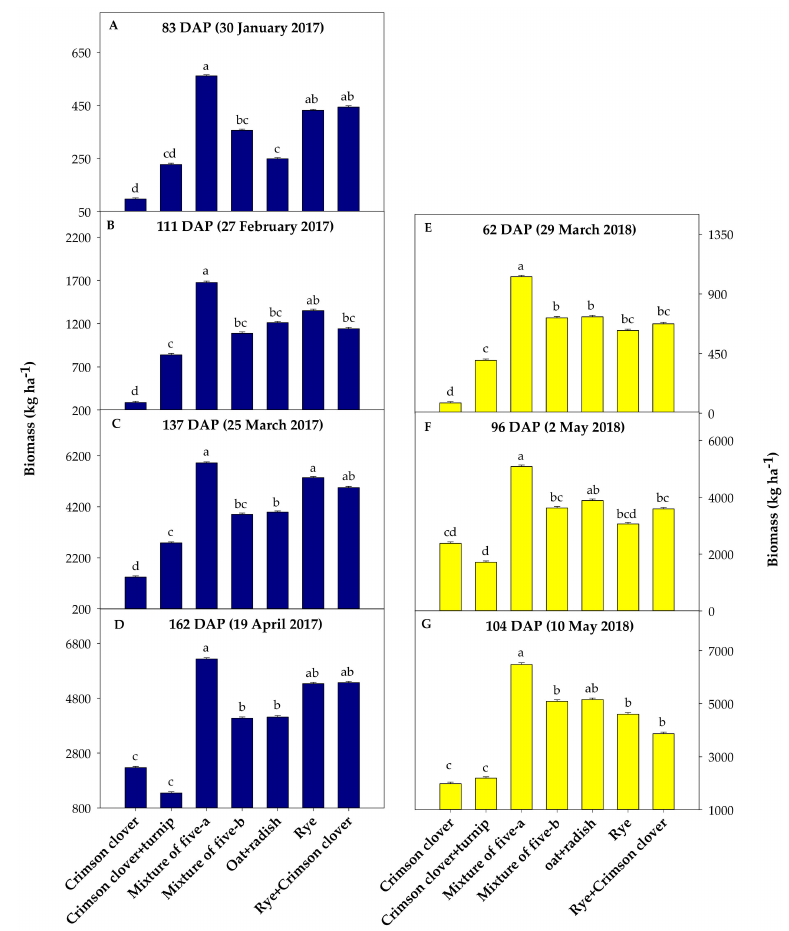
Figure 3. Cover crop biomass production on various measurement dates in ( A – D ) season-1 (2016–2017) and ( E – G ) season-2 (2018). Bars (least squares means) with di ff erent letters are significantly di ff erent according to the least significant di ff erence (LSD) test at α = 0.05. Mixture of five-a is a combination